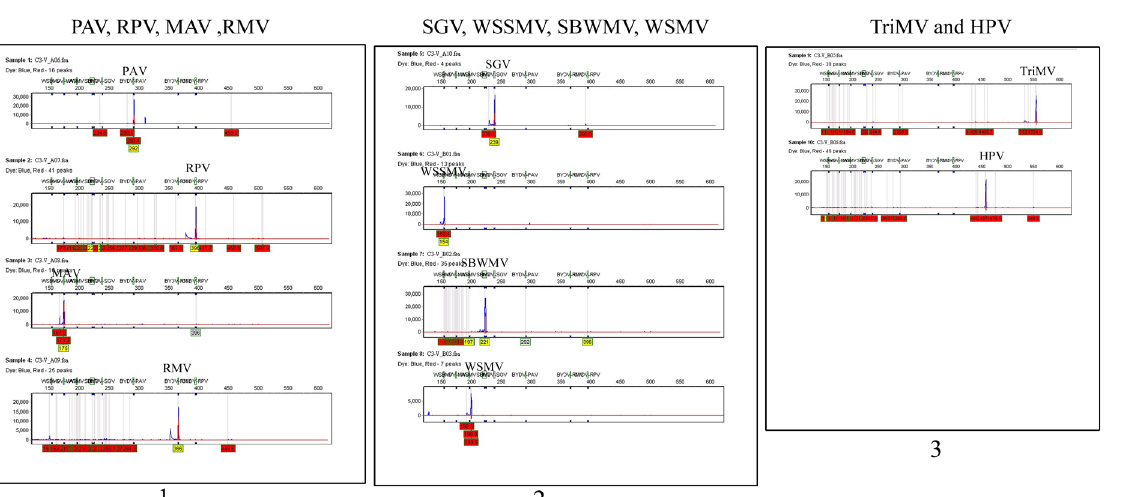
Figure 3. Specificity of the primers. Multiplex RT-PCRs (MLX) were carried out with a pool of con- trol virus samples. A set of virus-specific primers were sequentially deleted from each M-RT-PCR (Lanes 2–11). M-RT-PCR without the TriMV-specific primers shows no band for TriMV (Lane 10) and amplification without HPV primers did not give HPV band (Lane 11). This can be visually com- pared with the control eight- and ten-virus multiplex (Lane 13 and 14, respectively). Lanes 1 and 15 contain a 100 bp molecular marker ladder for reference.